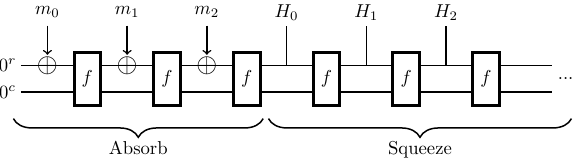
Figure 1: Sponge construction with three block input m 0 || m 1 || m 2 and three block output H 0 || H 1 || H 2 . With 0 r , 0 c we denote the all-zero bit string of length r, c . The application of the padding function is not